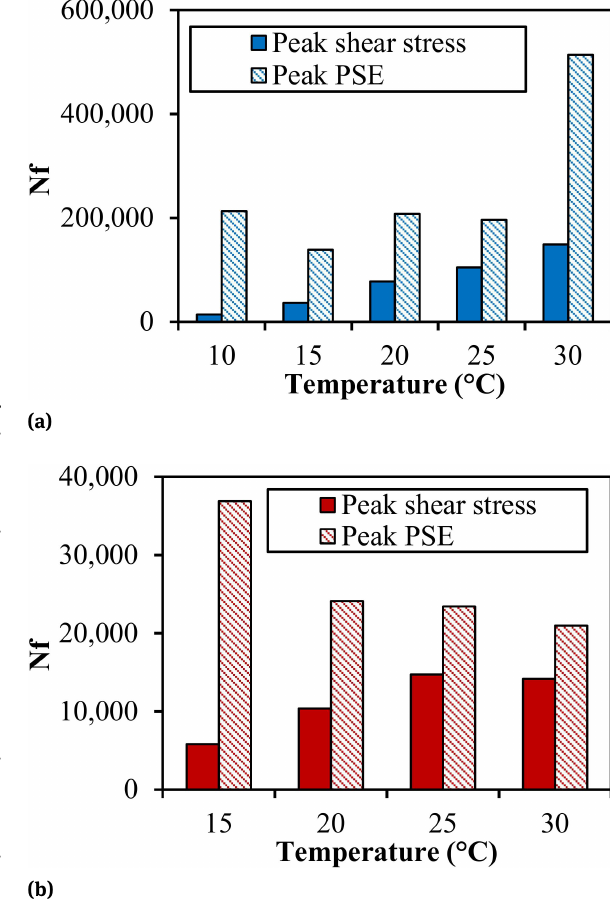
Figure 5: Results from two failure criteria: (a) HPMB and (b) AC